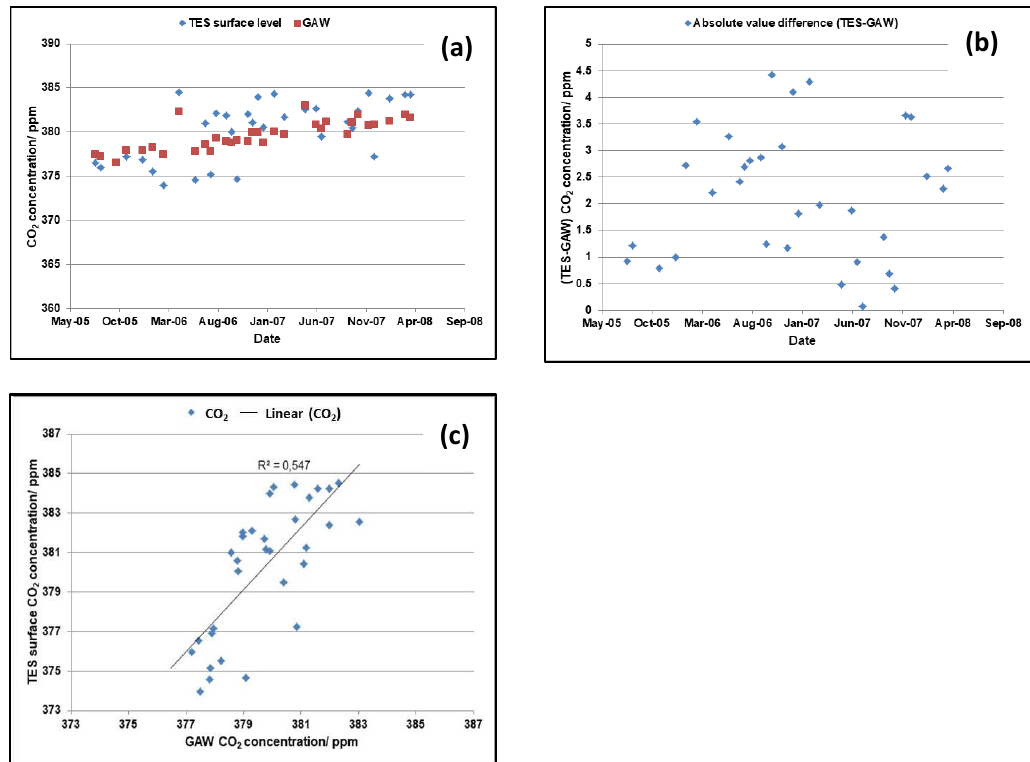
Figure 3. Comparison of the Tropospheric Emission Spectrometer (TES) surface and ground-based monitored Global Atmosphere Watch (GAW) Cape Point station CO 2 data. ( a ) Comparison of the TES surface and ground-based station CO 2 data. ( b ) The difference between the two datasets. ( c ) Scatter plot between the TES and ground-based observations at Cape Point; the black line represents the regression line between the two observations.